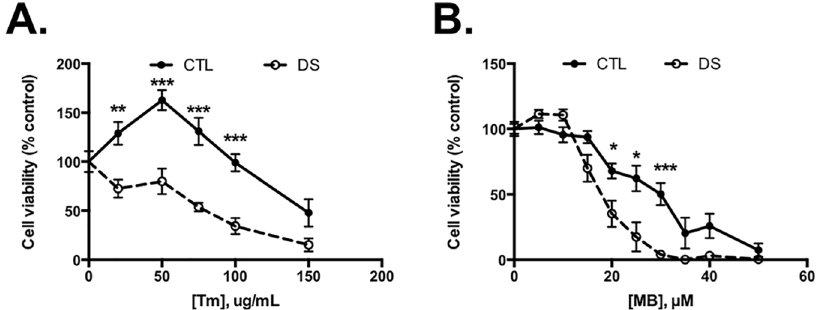
Fig 9. Cell viability in DS cells is altered to a greater extent due to exposure to ER stressorscompared to CTL. Cells were treated for 24h with Tm (A) or MB (B) and cell viabilitywas assessed using a WST-1 assay. N = 3–4, * P < 0.05; ** P < 0.01; *** P <